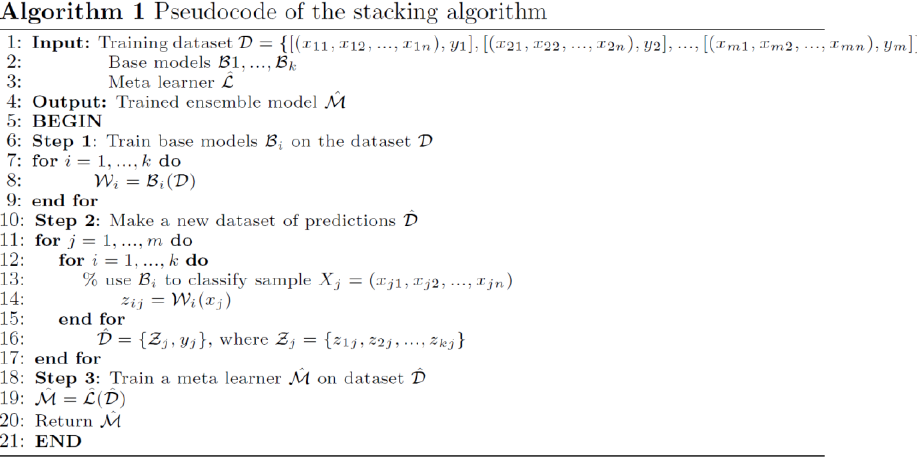
Figure 3. Algorithm of ensemble learning in pseudocode.